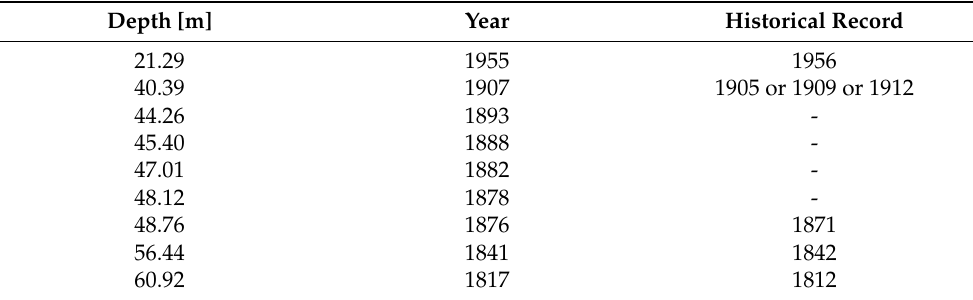
Table 3. Visible volcanic deposits obtained from an ice-core probe